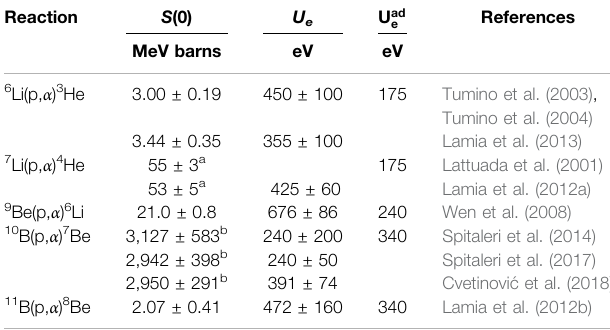
TABLE 3 | Overview of THM astrophysical S(E)-factor and electron screening potentialforthediscussed reactions.Theoreticalvaluesfor electron screening potential according to the adiabatic approximation U ad e are reported for